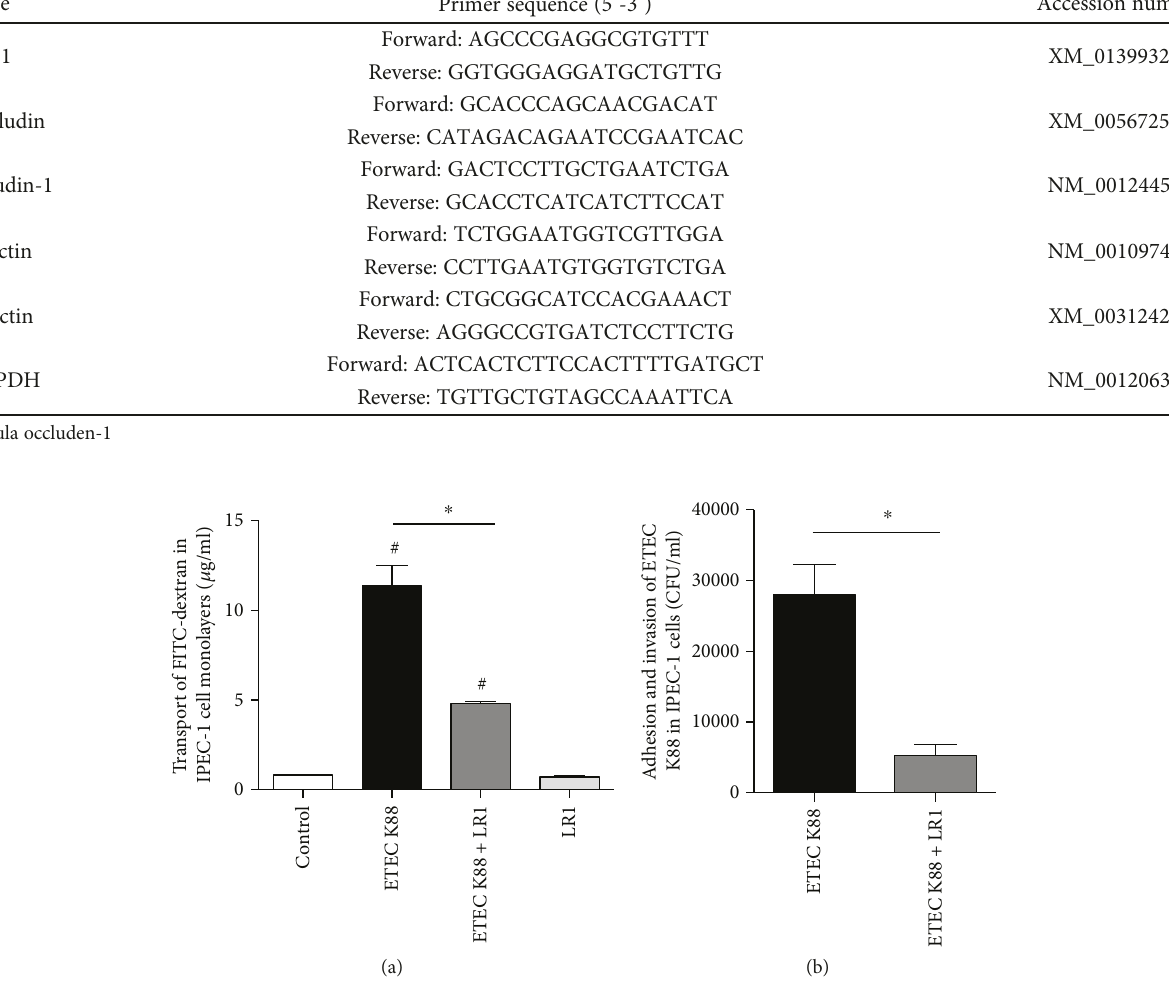
Figure 1: Permeability of IPEC-1 cell monolayers. (a) The transport of FITC-dextran across the IPEC-1 cell monolayers. (b) The adhesion and invasion of ETEC K88 in the IPEC-1 cell monolayers. All data are expressed as the mean ± SEM ( n = 6 ) and representative of 3 independent experiments. Di ff erences were determined by one-way ANOVA. # P < 0 05 compared with control, ∗ P < 0 05 .